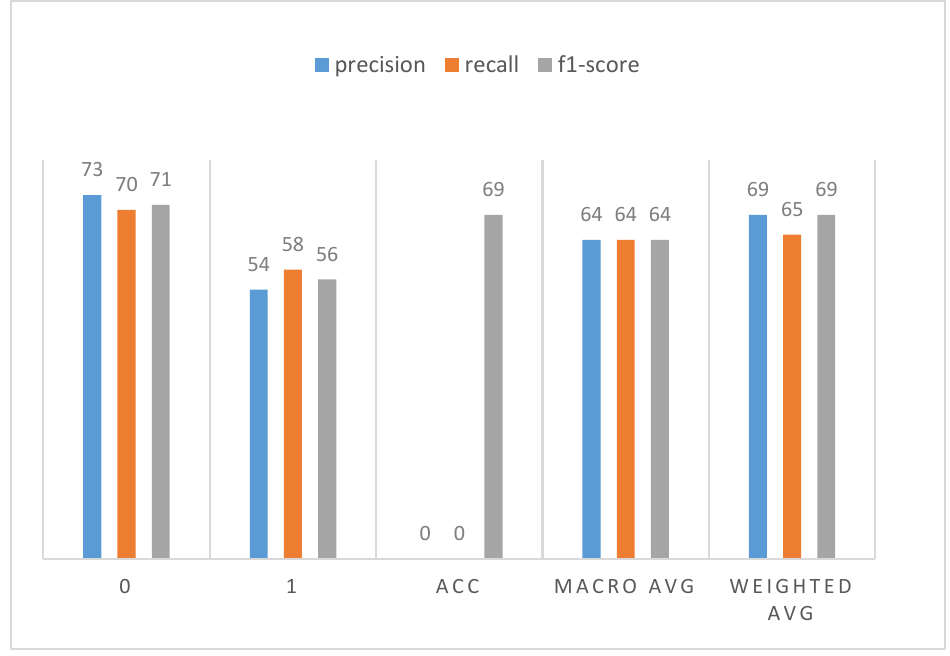
Figure 10. Summary of results for a testing dataset equal to 10% and training dataset of 90%. used, in contrast to the range for class (1). The value of the macro mean remained constant, while the values of the weighted mean varied slightly for each